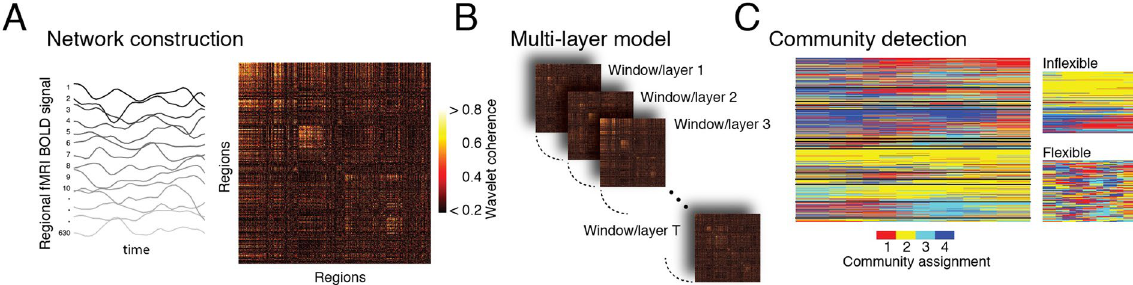
Figure 1. Schematic figure illustrating network construction, multi-layer network model, and community detection output. ( A ) Functional connectivity networks were generated by calculating the magnitude squared wavelet coherence for all pairs of regional fMRI BOLD time series 73 . The resulting coherence estimates are arranged in a region-by-region functional connectivity matrix. ( B ) Functional connectivity matrices for non- overlapping windows were arranged sequentially to form a multi-layer network – each layer corresponds to a window of time during the fMRI scan session 12 . For the purpose of multi-layer community detection, each brain region was coupled to itself across sequential windows. ( C ) Typical output of the multi-layer community detection algorithm 20 . Each network node (brain region) is assigned to a community in each layer. Here we show an example where four communities were detected. The consistency of those communities across adjacent layers determines a region’s flexibility 12 . The sub-panels show the 10% least flexible (top) and most flexible (bottom) brain